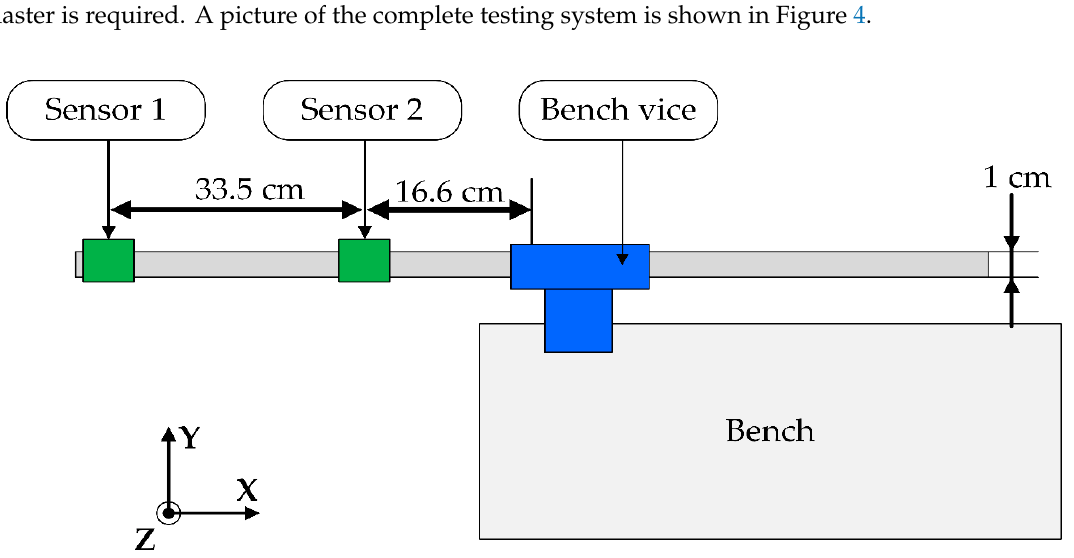
Figure 3. Testing the structure for the identification of the damage indicator.